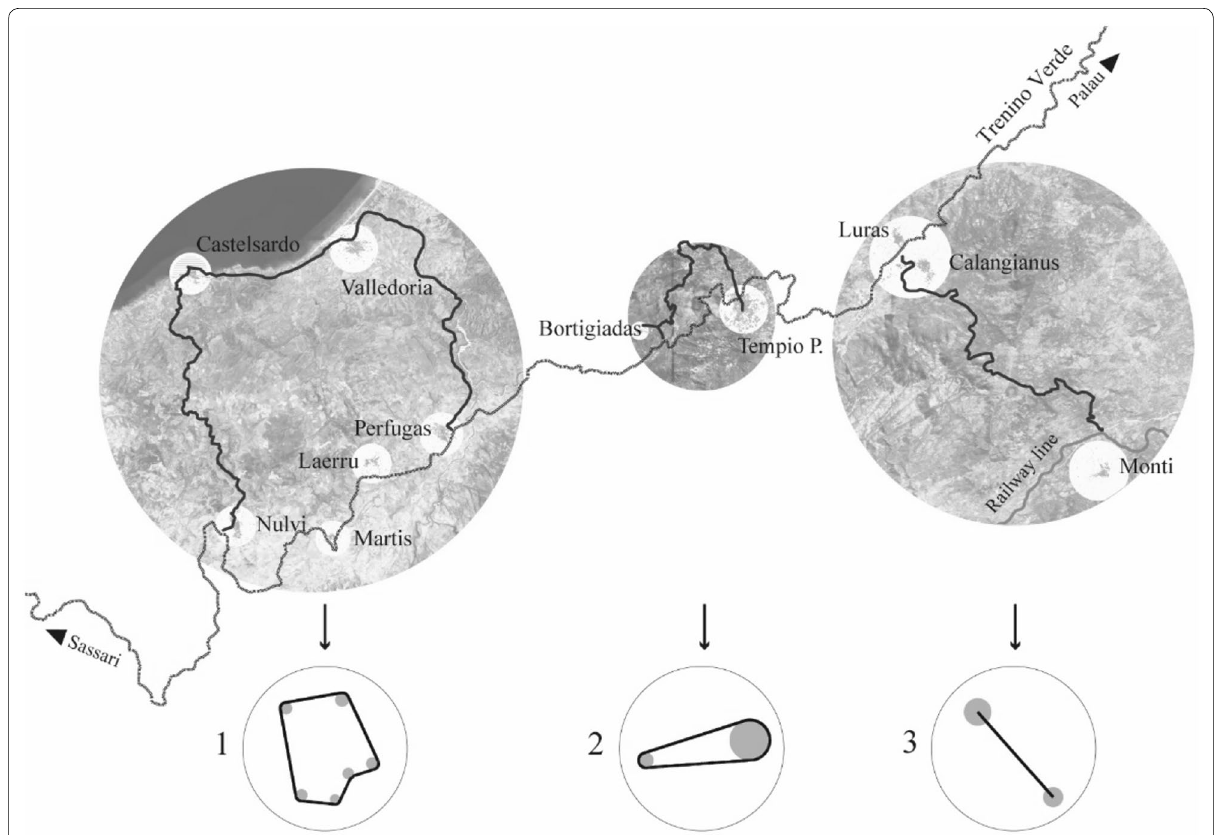
Fig. 9 Plan of the new cycle tourist paths in relation with the Trenino Verde